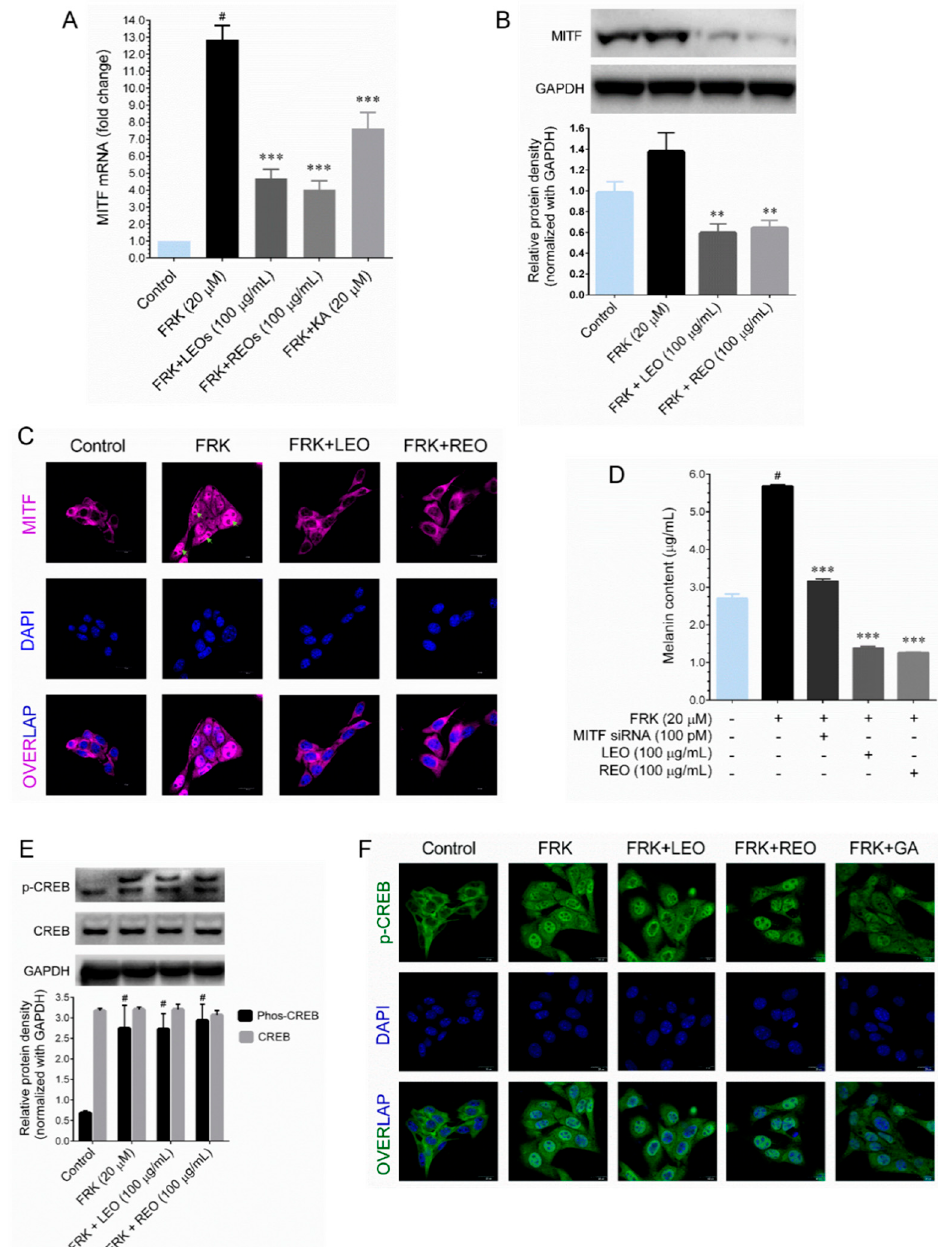
Figure 2. E ff ect of LEO and REO on Microphthalmia-associated transcription factor (MITF) transcriptional activity. ( A ) The mRNA expression level of MITF was determined by Q-PCR after treatment with 6 h. The protein expression level of MITF was determined by western blot analysis. ( B ) Protein expression level of MITF was determined by Western blot analysis and the histogram showed relative protein expression, which was normalized with loading control GAPDH. ( C ) Cellular localization of MITF was determined by immunofluorescence with fluorescein isothiocyanate (FITC)- conjugated secondary antibody. ( D ) The e ff ect of LEO and REO on melanin content was determined in cells transiently transfected with MITF siRNA or control siRNA. ( E ) The protein expression levels of CREB and Phos-CREB were determined by immunoblotting. ( F ) Cellular localization of Phos-CREB was measured by immunofluorescence after treatment with FRK in the presence or absence of LEO, REO and gallic acid (GA). Data represent the mean ± SD of three experiments. Statistical significance was set at # p < 0.05 compared to control vs. FRK and *** p < 0.001 compared with FRK + sample treatment groups vs. control group.